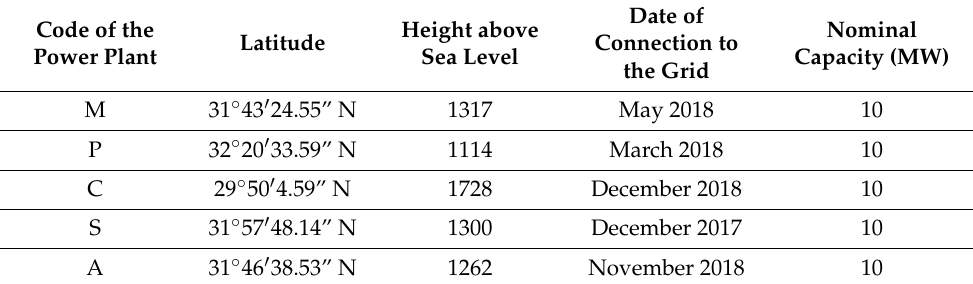
Date of Nominal Height above Connection to Latitude Capacity Sea Level the Grid